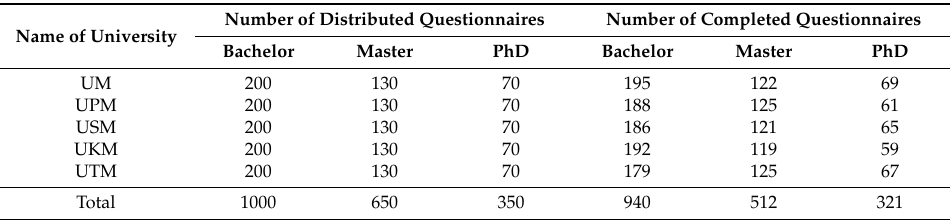
Table 2. Sample distribution.